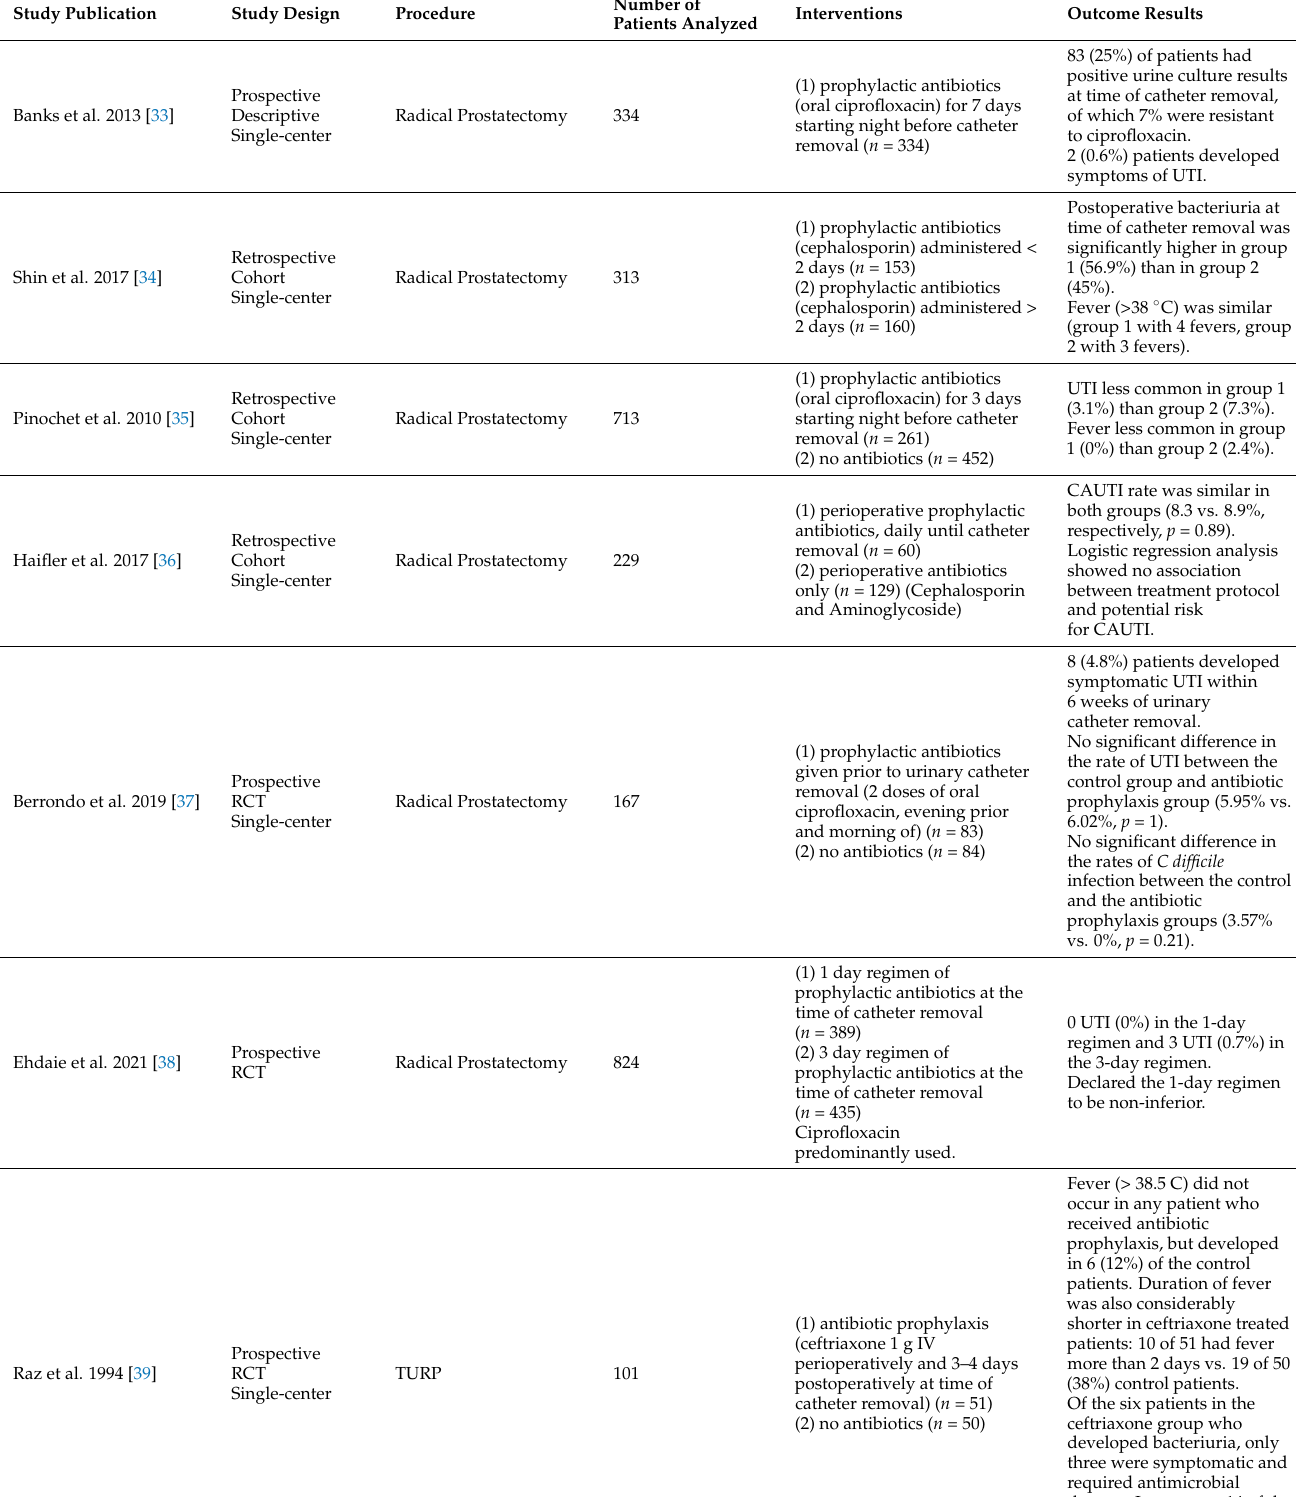
Table 3. Summary of Articles